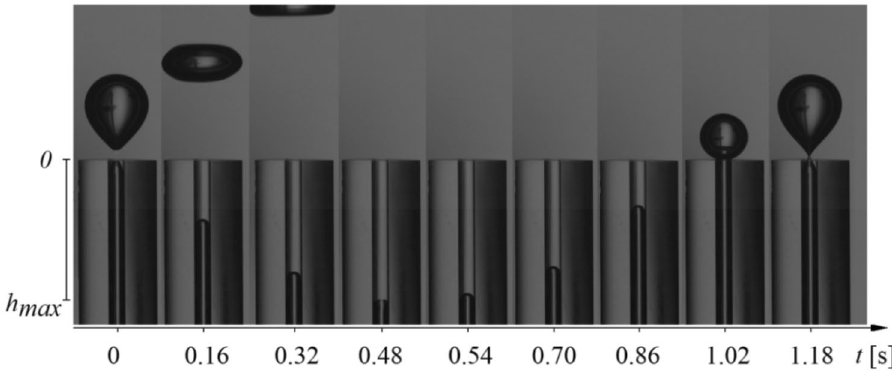
Figure 2. Subsequent video frames of water penetration into a capillary for an air volume flow rate of 0.014 l/ min (the air is represented by dark